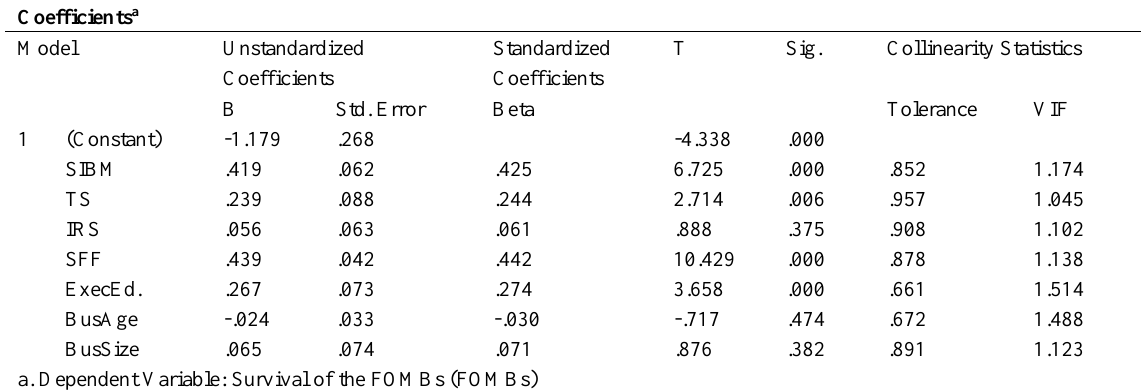
Table 6: Coefficients of multiple linear regression